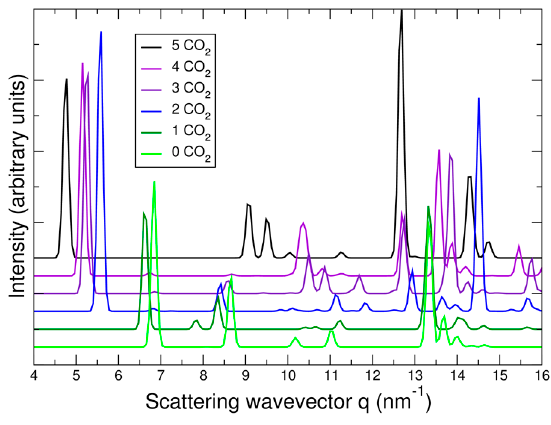
Figure 9. X-ray powder diffraction patterns of minimum energy DFT structures in NiBpene versus carbon loading.